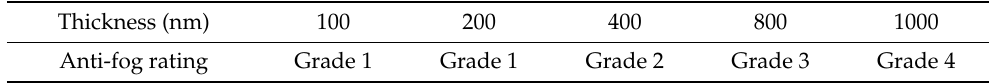
Figure 3. Anti-fog effect of film samples with different film thicknesses: ( a ) 100 nm; ( b ) 200 nm; ( c ) 400 nm; ( d ) 800 nm; ( e ) 1000 nm. Table 2. Anti-fog rating table of film samples with different film thicknesses.